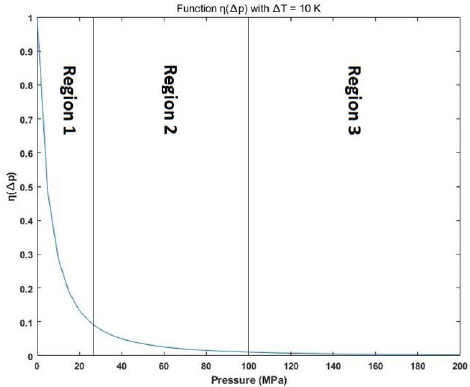
Figure 8. Typical curve of ( ) 0 , p T η ∆ ∆ according to Equation 45, presenting 3 distinct regions.